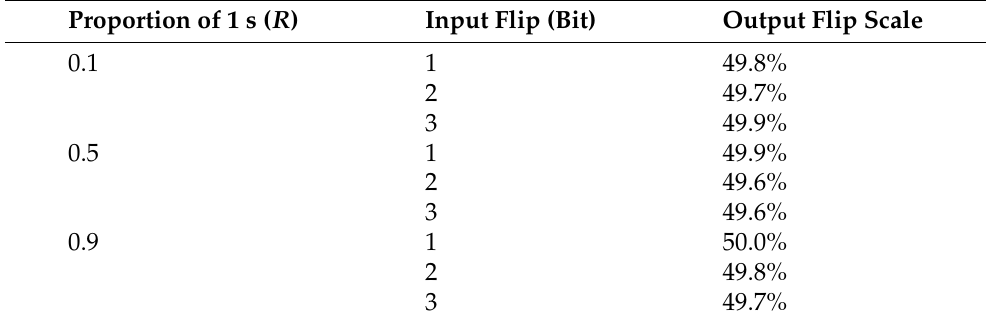
Table 7. Influence of CA initial